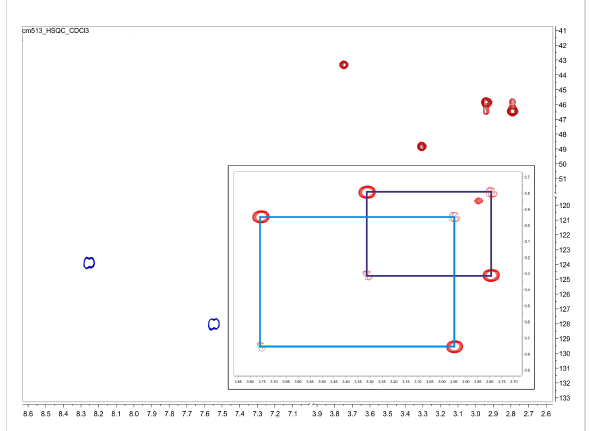
Figure 2: HSQC and H,H-COSY (small spectrum) of compound 3a measured in CDCl 3 at 25 °C. The independent coupling of the NCH 2 groups is marked.